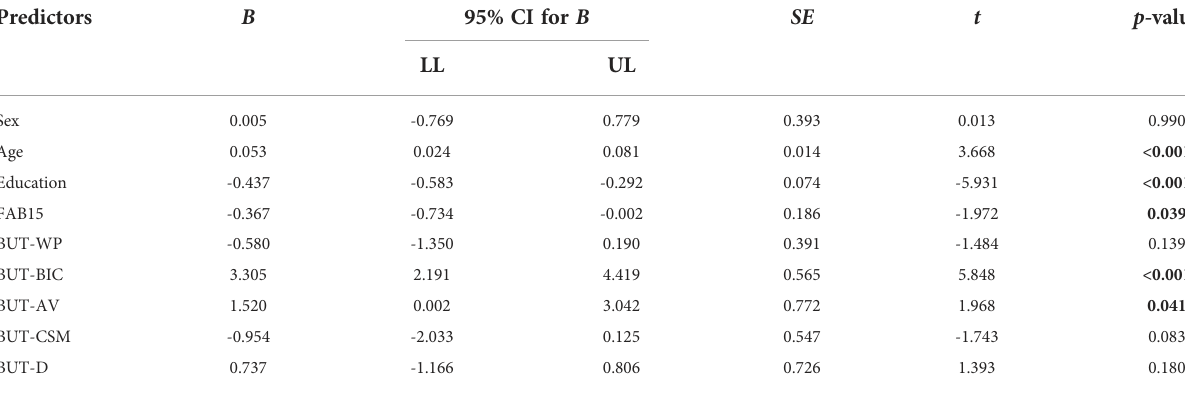
TABLE 2 Results of the Multiple Linear Regression Analysis on